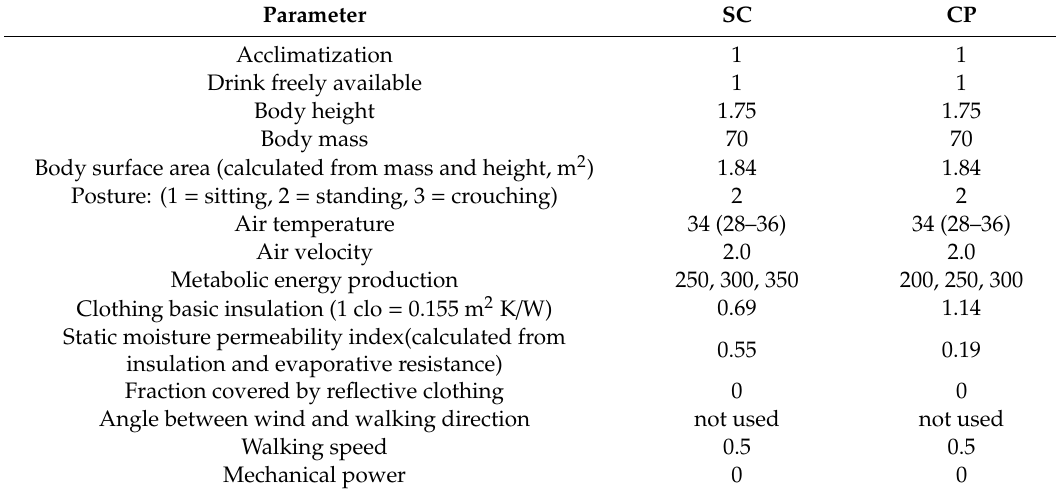
Table 1. Input to predicted heat strain model (PHS) for the high humidity (RH = 70%)